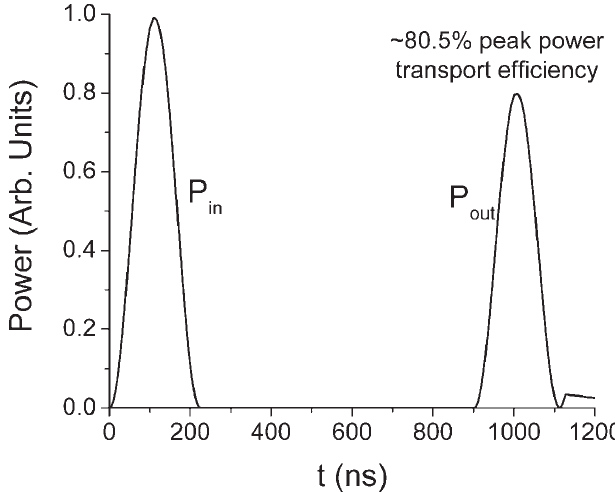
FIG. 12. Incident ( P ) and transmitted ( P ) power pulse in out waveforms from an exponential impedance transformer (design II) as represented by 41 elements in the transmission-line